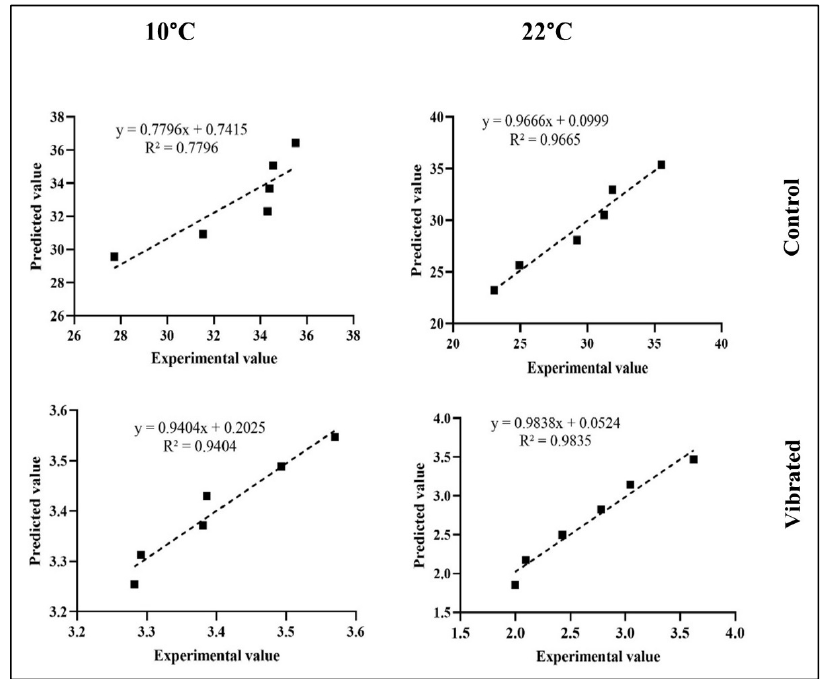
Figure 11. Predicted and experimental results of b* change kinetic of vibrated and non-vibrated (control) tomatoes stored at 10 °C and 22 °C .